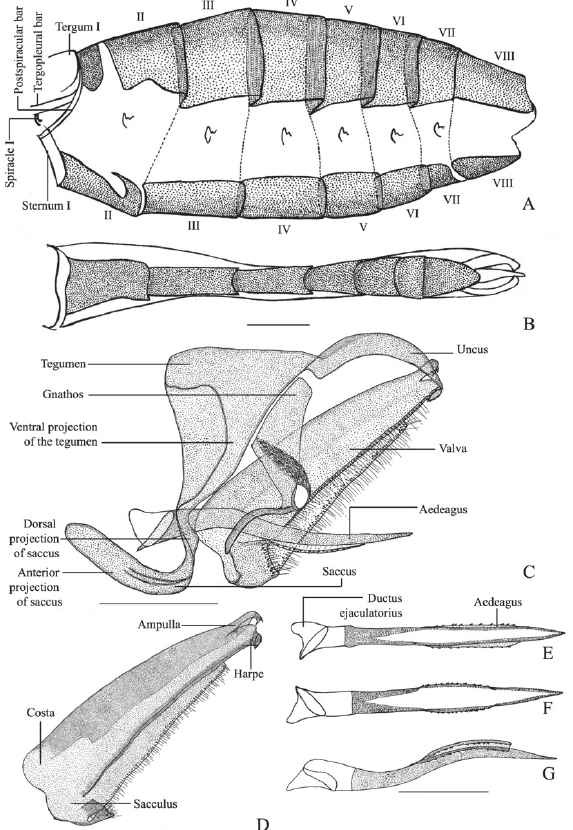
Figure 9. Female genitalia of Junonia lemonias (Linnaeus, 1758) A – C - abdomen (lateral, dorsal and ventral view); D - female genitalia (lateral view). Scale bar